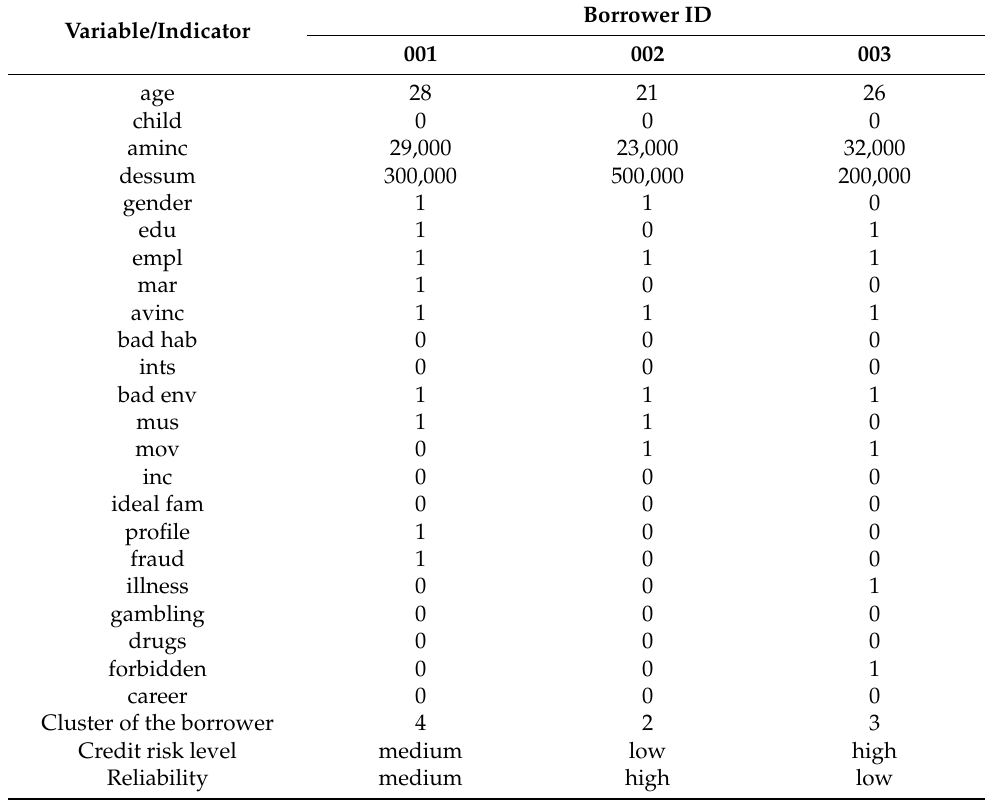
Table 13. Assessment of reliability and borrowers’ risk according to the proposed